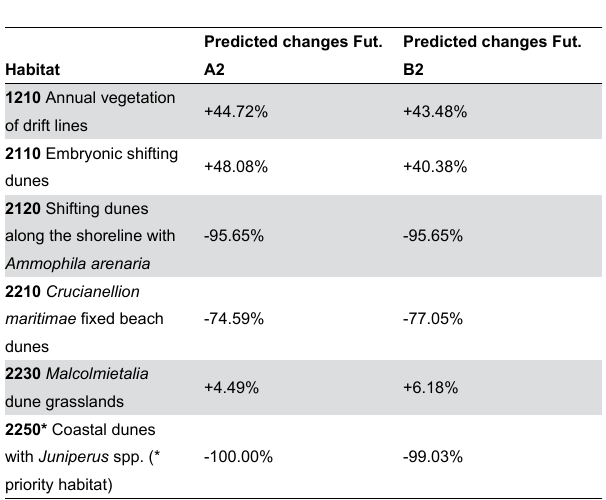
Table 3. Indirect models